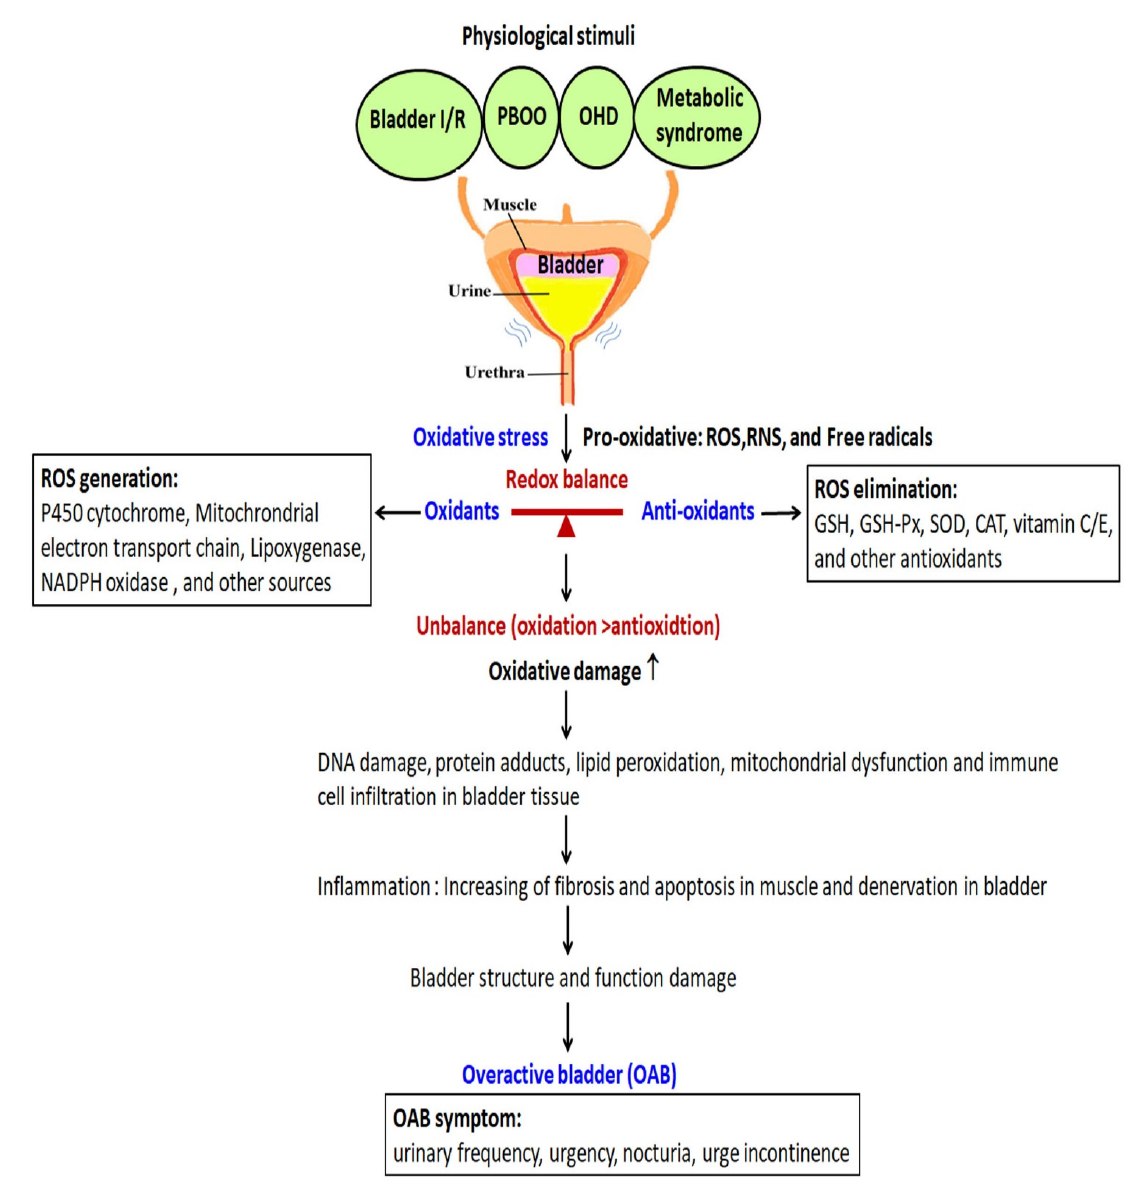
Figure 1. Disorders associated with oxidative stress and overactive bladder (OAB), including bladder I/R, PBOO, metabolic syndrome, and ovary hormone depletion (OHD). OAB syndrome includes frequency, urgency, nocturia and urgency incontinence. The occurrence of OAB may result from an imbalance between the production of pro-oxidants and their elimination through antioxidants. Several animal models mimic the physiological condition to induce OAB, such as bladder ischemia/reperfusion (I/R), partial bladder outlet obstruction (PBOO), metabolic syndrome and ovarian hormone deficiency (OHD). Oxidative stress is regulated by the balance between pro-oxidative and antioxidative factors. Oxidative stress increased the levels of cellular reactive oxygen species (ROS), reactive nitrogen species (RNS) and free radicals. The antioxidant defense system participates in scavengers of free radicals to decrease excessive ROS and protect against oxidative-stress-induced bladder dysfunction. Redox signaling is essential for the maintenance of homeostasis between oxidants (ROS generation) and antioxidants (ROS elimination). ROS are derived from nicotinamide adenine dinucleotide phosphate (NADPH) oxidase (NOX), xanthine oxidase, nitric oxide synthase (NOS) and cyclooxygenases’ mitochondrial respiratory chain. Cellular ROS levels are regulated by an enzymatic antioxidant system. The defense systems include enzymes such as superoxide dismutase (SOD), catalase (CAT) and glutathione peroxidase (GSH-Px). However, excessive production of ROS/RNS can cause oxidative stress, which results in DNA damage, protein adducts, lipid peroxidation, mitochondrial dysfunction and immune cell infiltration in bladder tissue leading to bladder denervation and increasing fibrosis and apoptosis, resulting in bladder